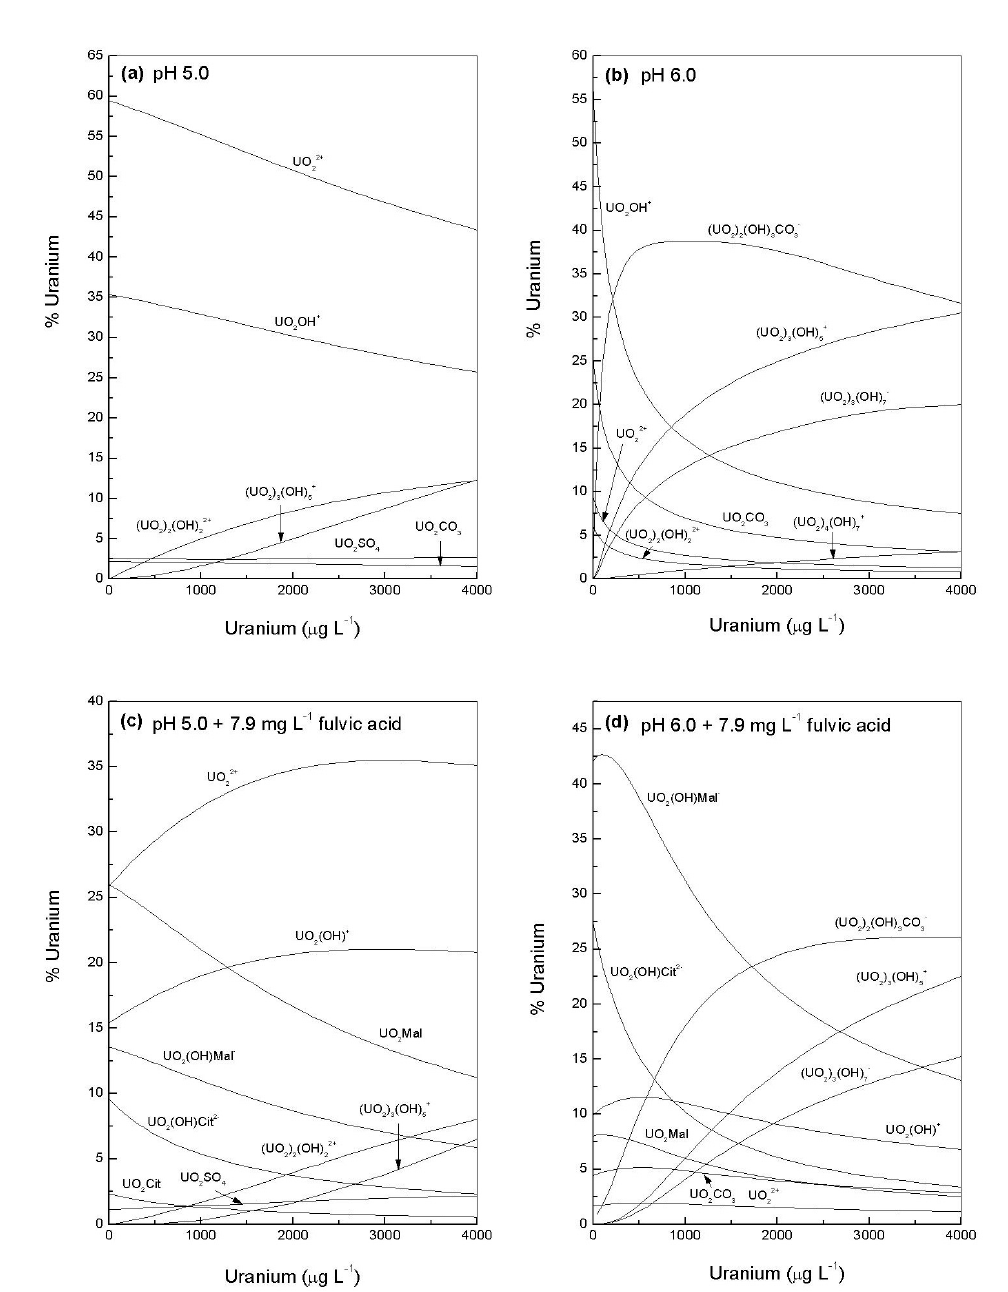
FIGURE 4. Predicted speciation (% distribution) of U in synthetic Magela Creek water at (a) pH 5.0 without model fulvic acid (FA); (b) pH 6 without model FA; (c) pH 5 with 7.9 mg l -1 model FA; and (d) pH 6 with 7.9 mg l -1 model FA.